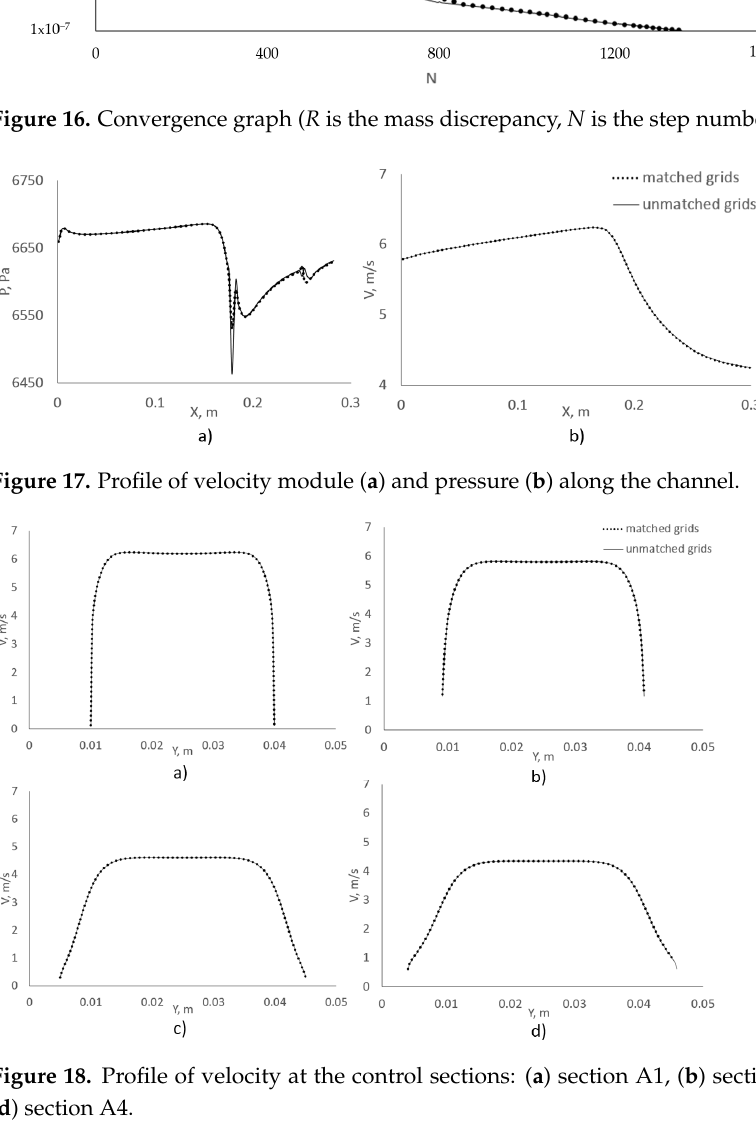
Figure 16. Convergence graph ( R is the mass discrepancy, N is the step number).